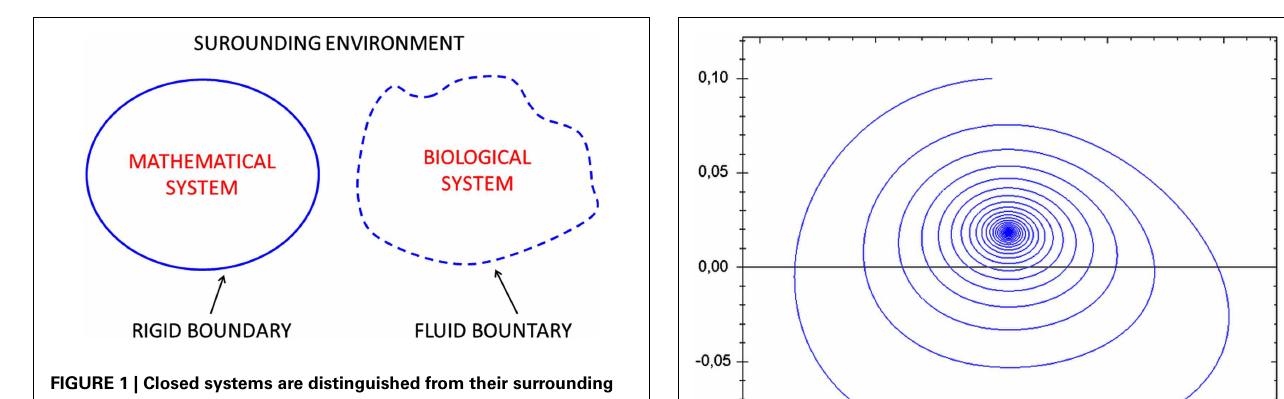
FIGURE 1 | Closed systems are distinguished from their surrounding environments by definitive boundaries, firm (left) or fuzzy (right).